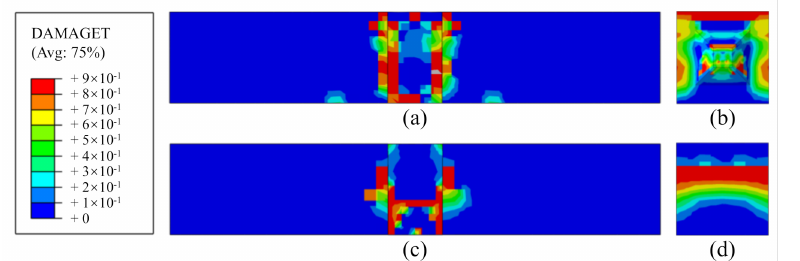
Figure 10. Contour plots of damage for ( a ) S-SWJ and ( b ) its bridge panel end and ( c ) S-CWJ and ( d ) its bridge panel end when the specimen reaches the maximum load.